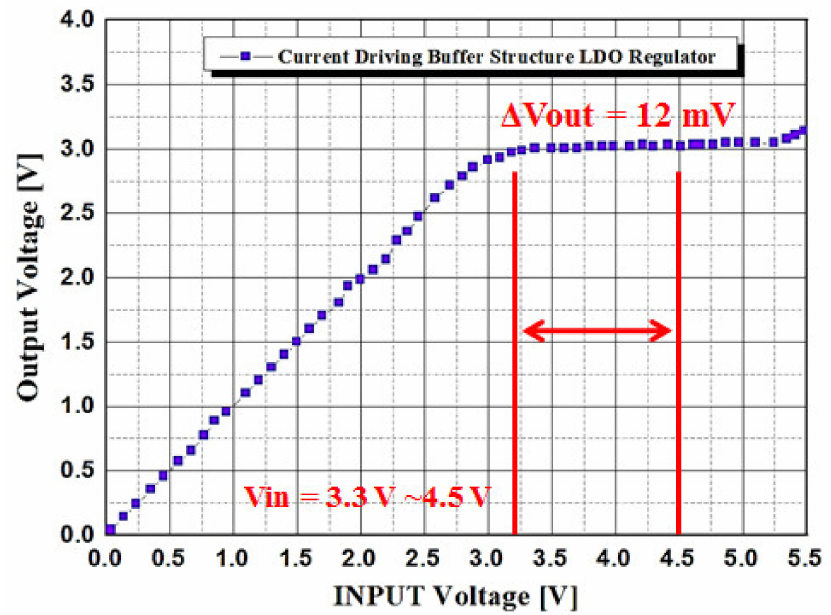
Figure 14. Line regulation of the proposed LDO regulator.